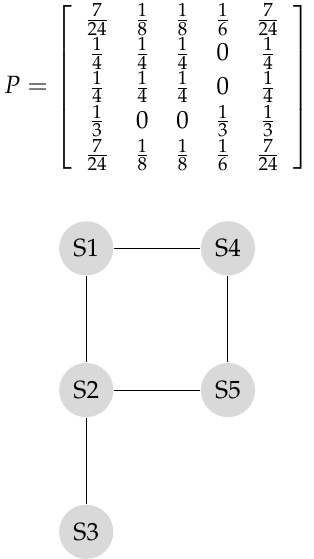
Figure 1. Original unipartite graph.